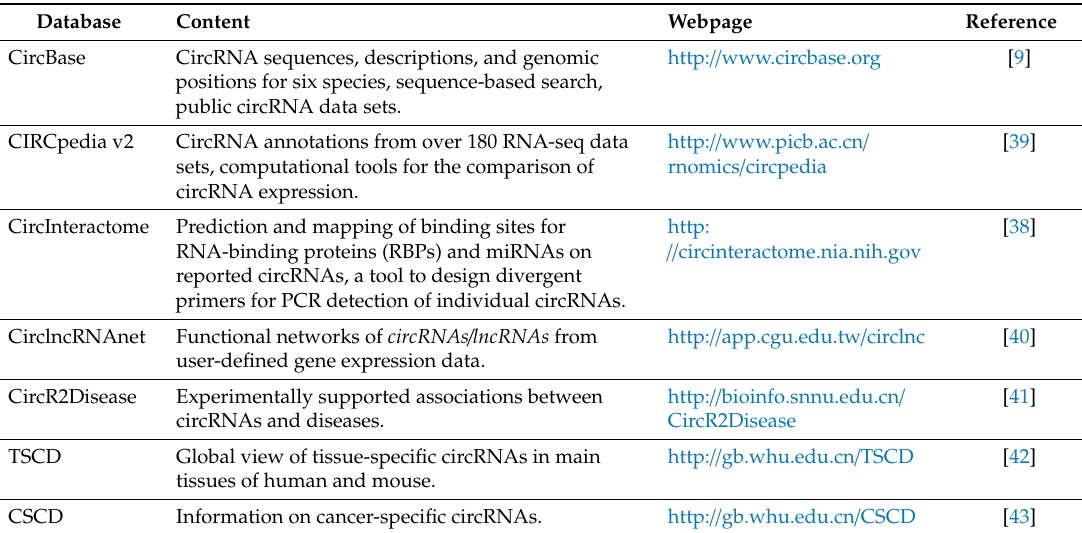
Table 1. CircRNA